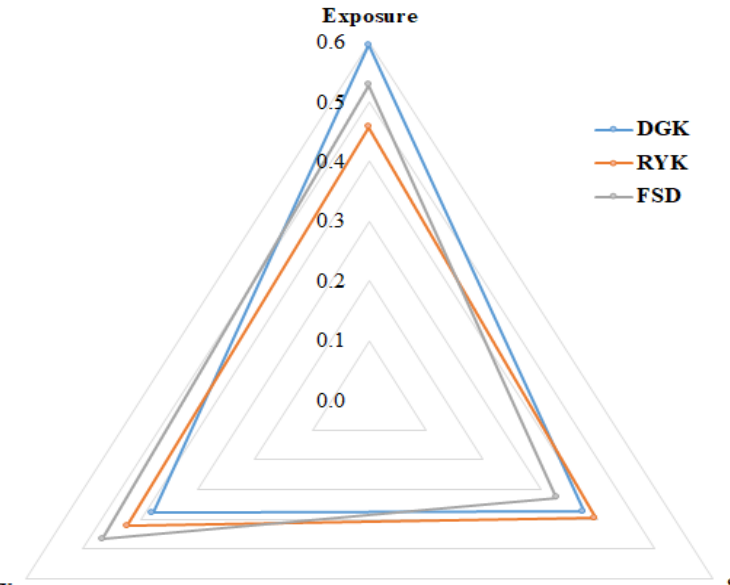
Figure 7. Spider diagram of vulnerability based on major components of LVI of the study area. The LVI-IPCC scale ranged from −1 (less-vulnerable) to 1 (most-vulnerable). Small livestock herders in the DGK were vulnerable to CC in terms of exposure (0.595) with lower adaptive capacity (0.378). Moreover, respondents in FSD were also vulnerable alt- hough less exposed (0.528), having lower sensitivity to CC (0.328) and a higher level of adaptive capacity (0.465) compared with DGK. The farmers in RYK were the least vulner- Table 6. Table LVI-IPCC contributing factors of three agro-ecological zones. able, despite being more sensitive (0.395) to CC with a lower level of exposure (0.458) and a higher level of adaptive capacity (0.422) compared with the other two districts (Table 6 and Figure 8). Table 6. Table LVI-IPCC contributing factors of three agro-ecological zones.